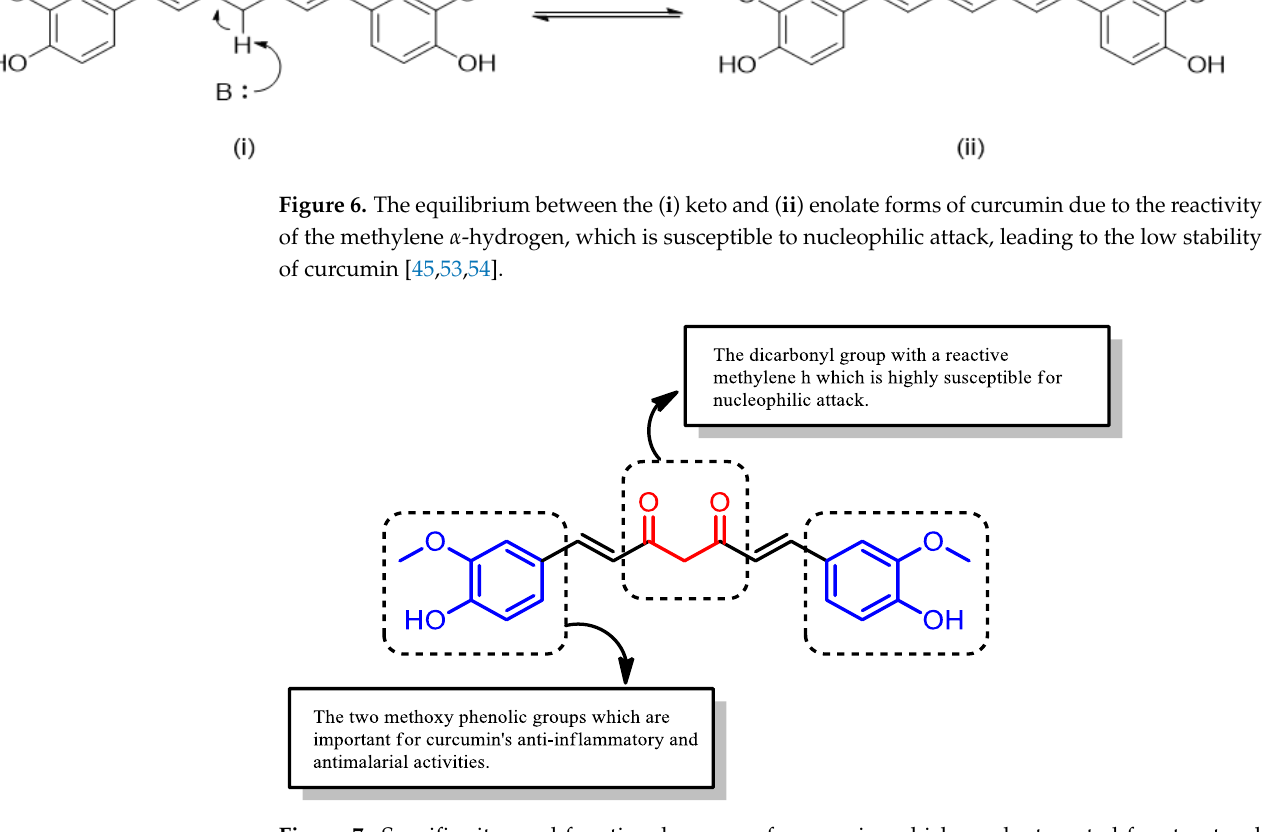
Figure 7. Specific sites and functional groups of curcumin, which can be targeted for structural mod- ifications.